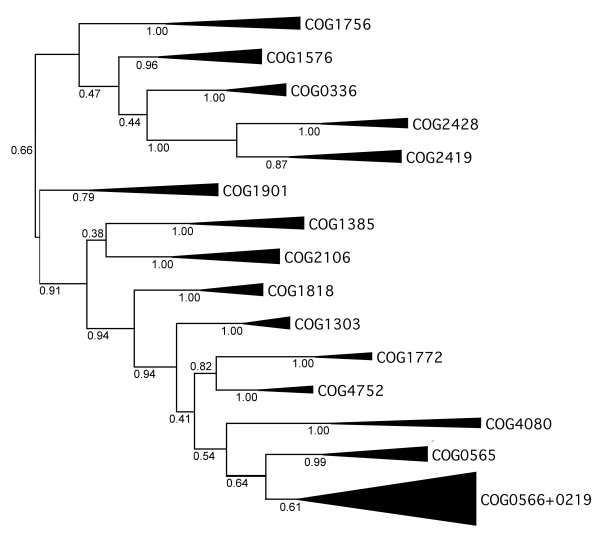
The unified Bayesian tree of SPOUT MTases calculated based on the sequence alignment in Figure 7 and the character matrix in Table 2. All branches are labeled with their posterior probabilities. Compared to the sequence-only tree, this tree shows improved support for deep branches and comparable support for terminal branches.